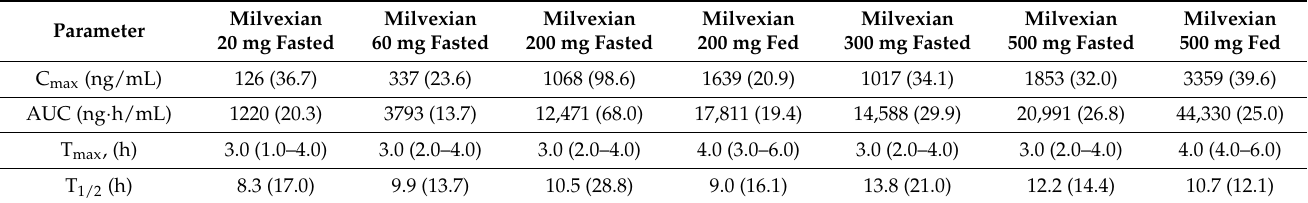
Table 8. Plasma pharmacokinetic parameters of milvexian. Geometric Mean (Geometric Mean CV%) milvexian PK parameters. For T max , data are presented as median (min-max). Data are from Perera, V et al. [33]. C max : Maximum plasma concentration; T max : time to reach C max . AUC: area under the curve; T 1/2 : half-life time.